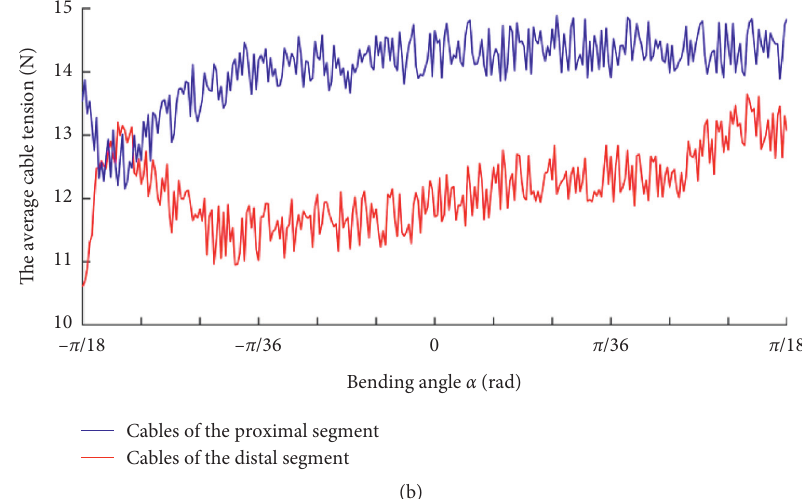
Figure 16: Cable tension during the bending motion of the distal segment. (a) Bending angle β (rad). (b) Bending angle α (rad).